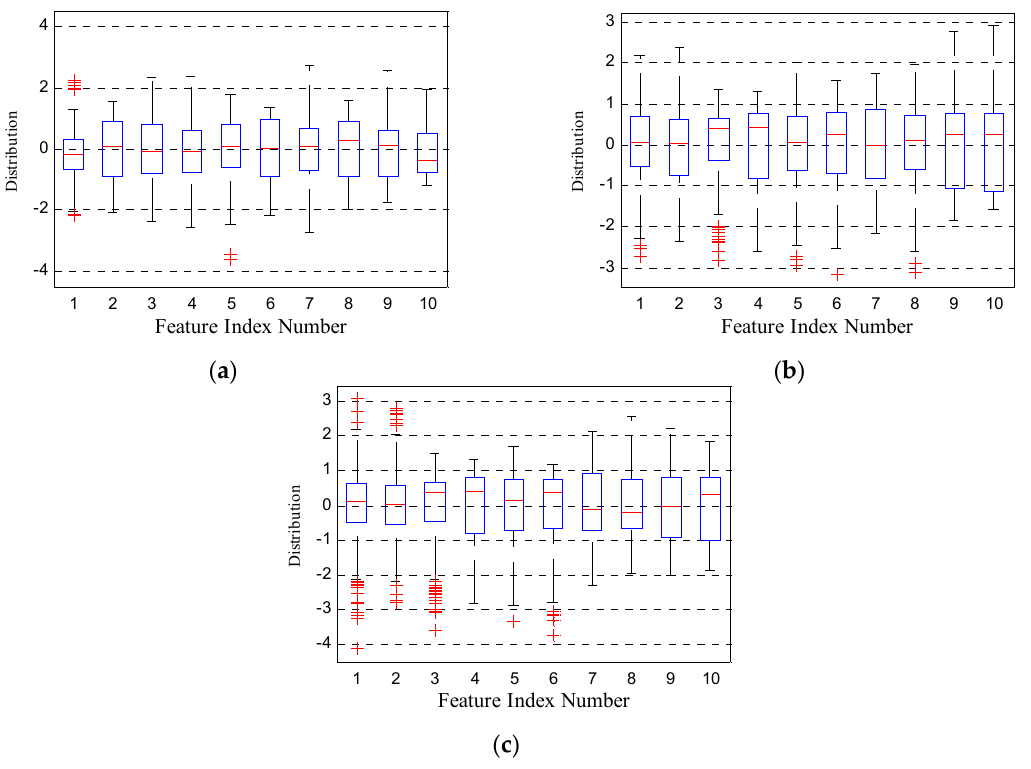
Figure 10. The feature distribution of three different real emitters after normalization. ( a ) Emitter 1. ( b ) Emitter 2. ( c ) Emitter 3 (real radar emitter).